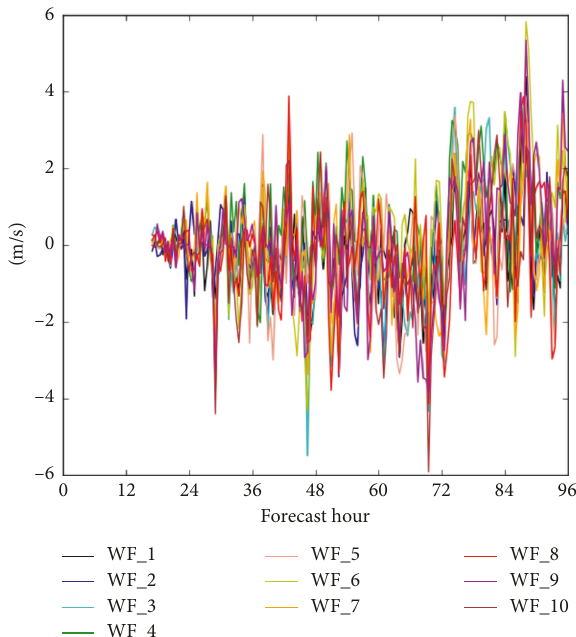
Figure 3: Example time series of cyclone maximum 10m wind speed perturbation from the control run. The case shown here represents the tropical cyclone case initialized on 24 August 2011 00Z.